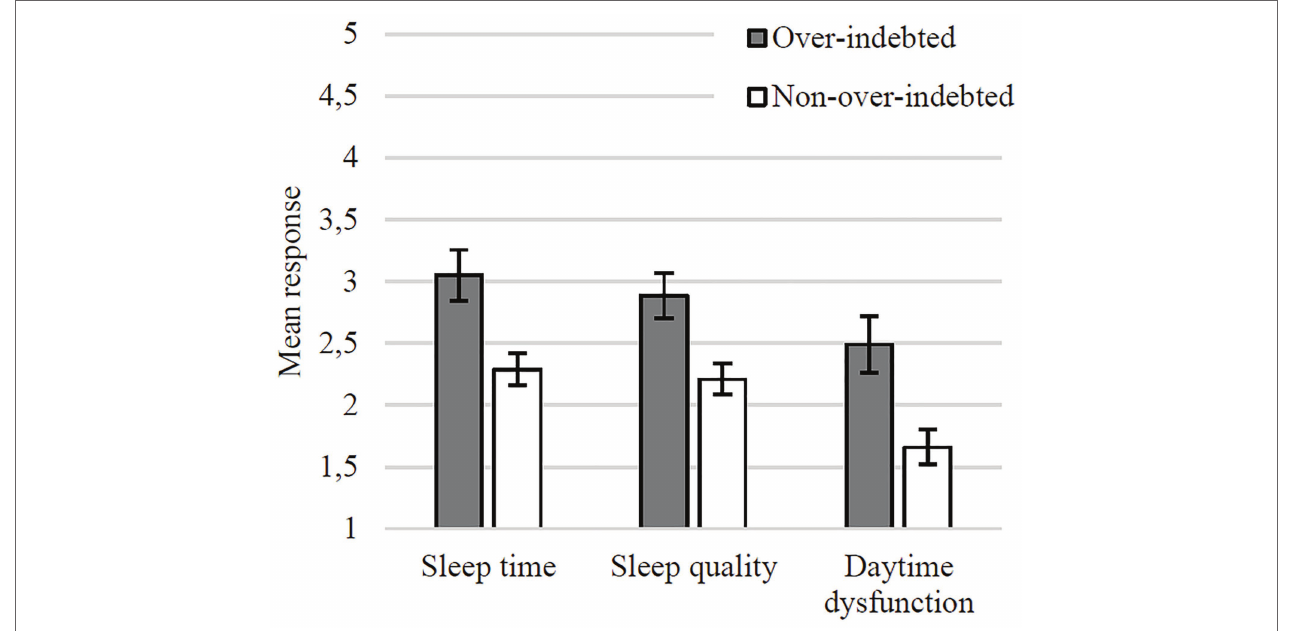
FIGURE 3 | Mean evaluations of sleep time and quality and daytime dysfunction (with SEs) in over-indebted and non-over-indebted